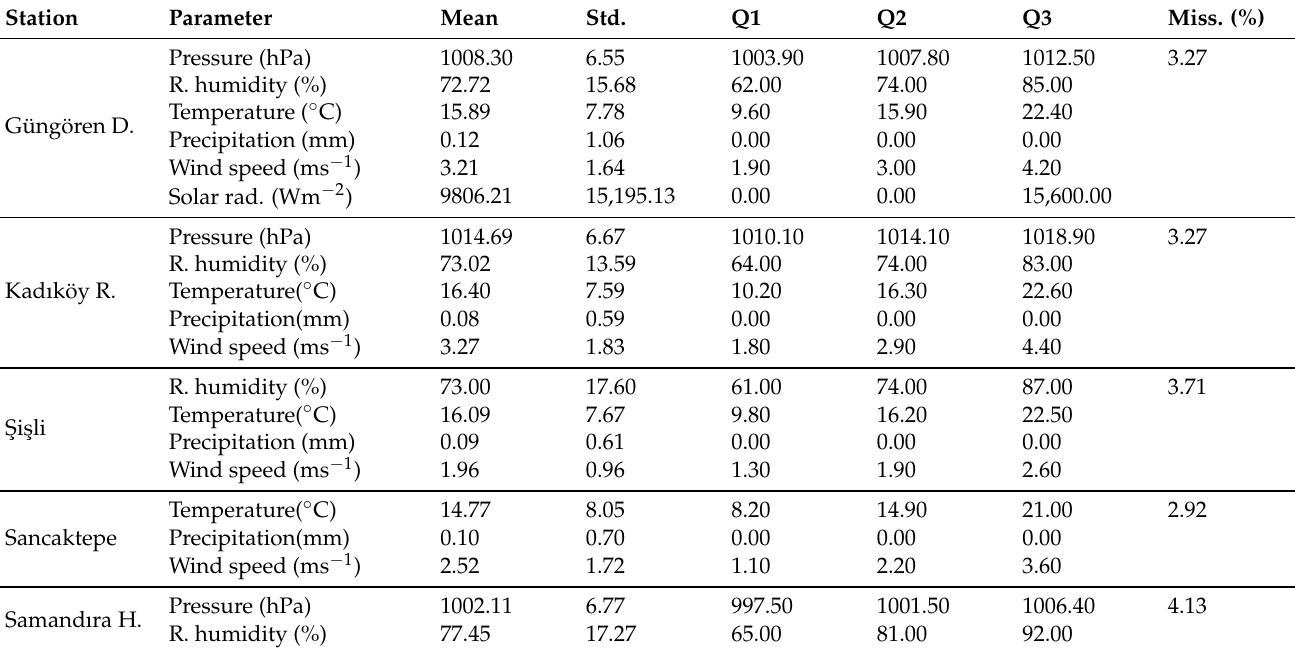
Table 2. Statistical summary of the meteorological stations’